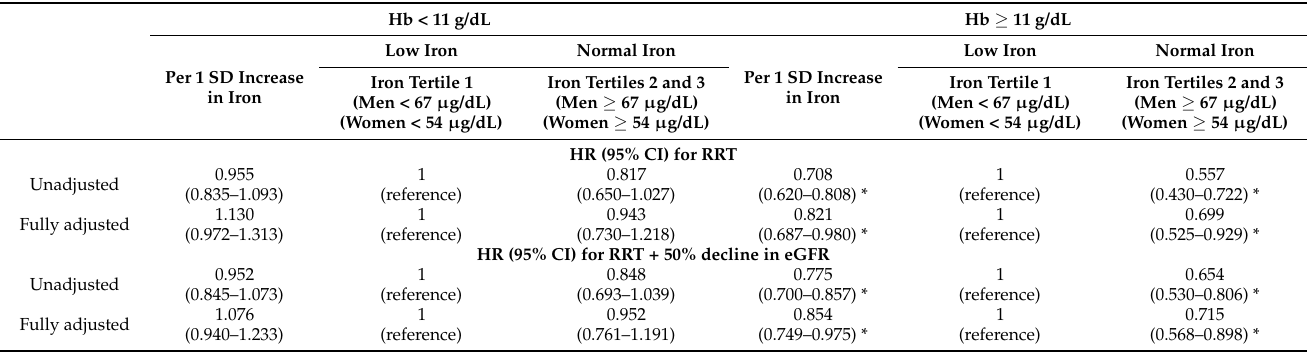
Table 5. Association of serum iron with renal outcomes divided by hemoglobin.